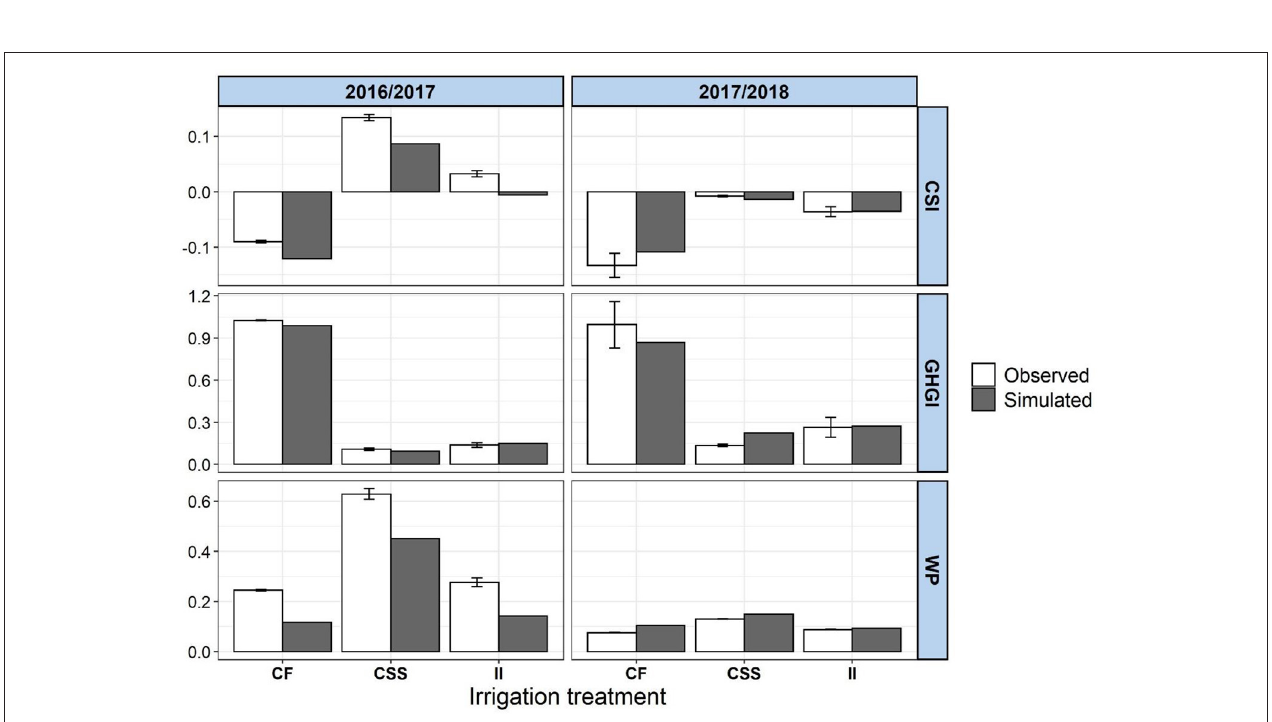
FIGURE 1 | Observed (white bars) and simulated (gray bars) data of Yield (kg ha − 1 ), methane (CH 4, kg CH 4 ha − 1 season − 1 ), Nitrous oxide (N 2 O, kg N 2 O ha − 1 season − 1 ) and Total Water Inputs (TWI, mm) for the 2016/20127 and 2017/2018 cropping seasons. Error bars represent the standard error.